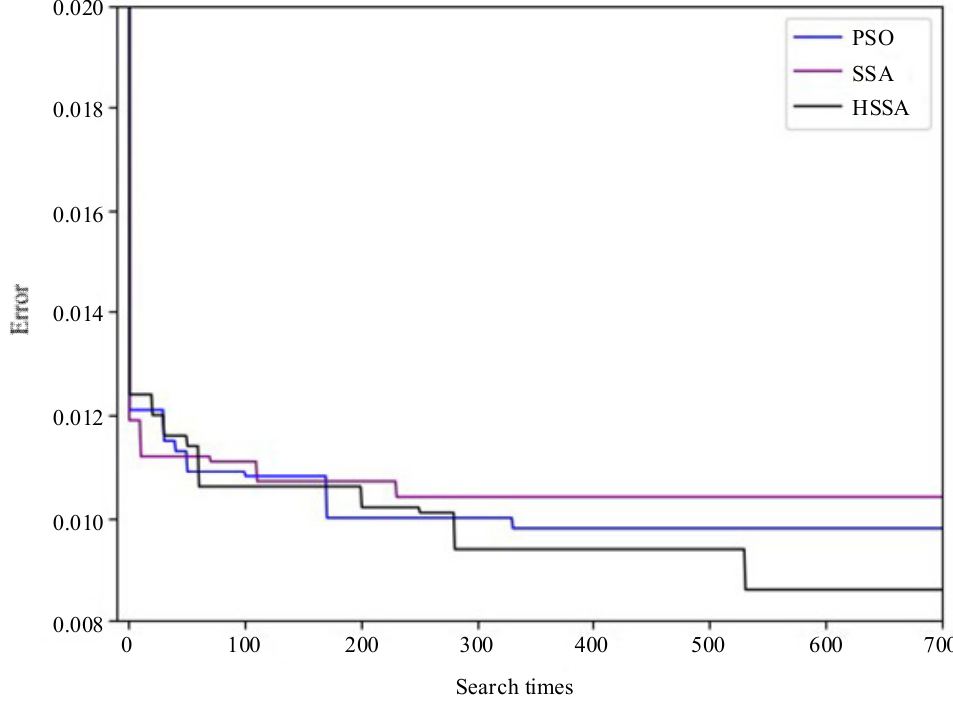
Figure 8. Results of the meaning verification experiment on MNIST.